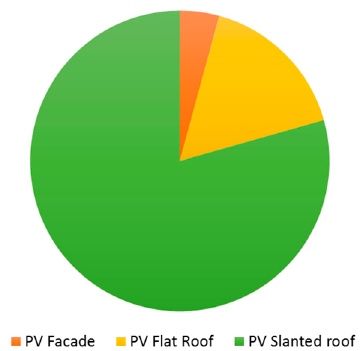
Figure 2. Energy production share for the emission minimization optimal solution.